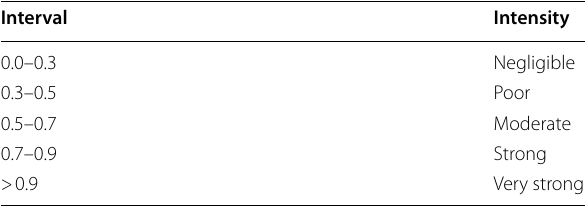
Table 1 Pearson correlation analysis